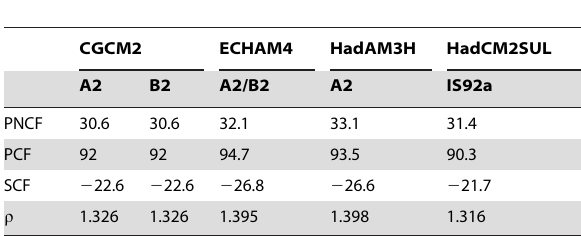
Table 4. Results of the variation partitioning of combined favourability